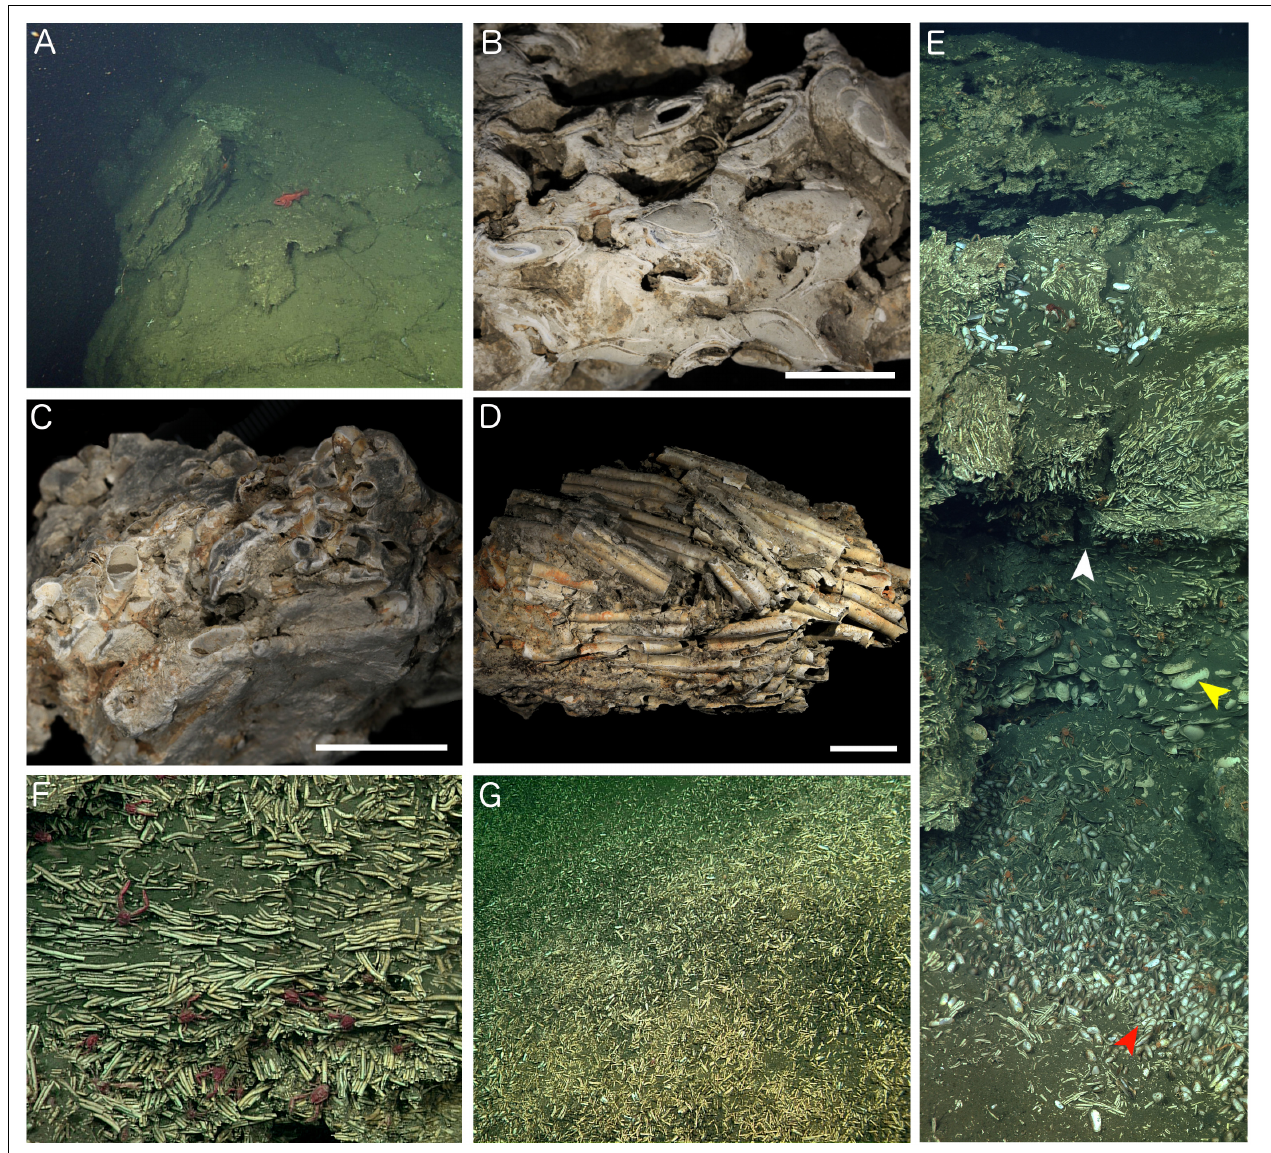
FIGURE 4 | Characteristics of Fossil Hill. (A) Large carbonate slabs on the edge of large pockmark structure ( Figure 1C ) which appear to be sliding into the hole (hole is to the left in the image). (B) Carbonate rock recovered south of the main Fossil Hill mound containing many preserved bivalves, sample DR630 R-3, and scale bar is 20 mm. (C) Fossil Hill carbonate with embedded worm tubes, sample DR629 R-2, and scale bar is 20 mm. (D) Densely packed and aligned tube fragments that are only weakly cemented by carbonate, DR626 R-4, and scale bar is 20 mm. (E) Mosaic of the wall of a small depression pictured in Figure 3 , showing interlayered fossil worm tubes and bivalve shells. Perspective of F (white arrow), large bivalve shells (yellow arrow), and smaller living bivalves (red arrow) are highlighted. (F) Detail of the fossil worm tubes from the depression in E (white arrow), showing that they are only weakly cemented together and are aligned in parallel. Red munidopsid squat lobsters were common. (G) Slope on the southern side of Fossil Hill littered with tube and bivalve hash.